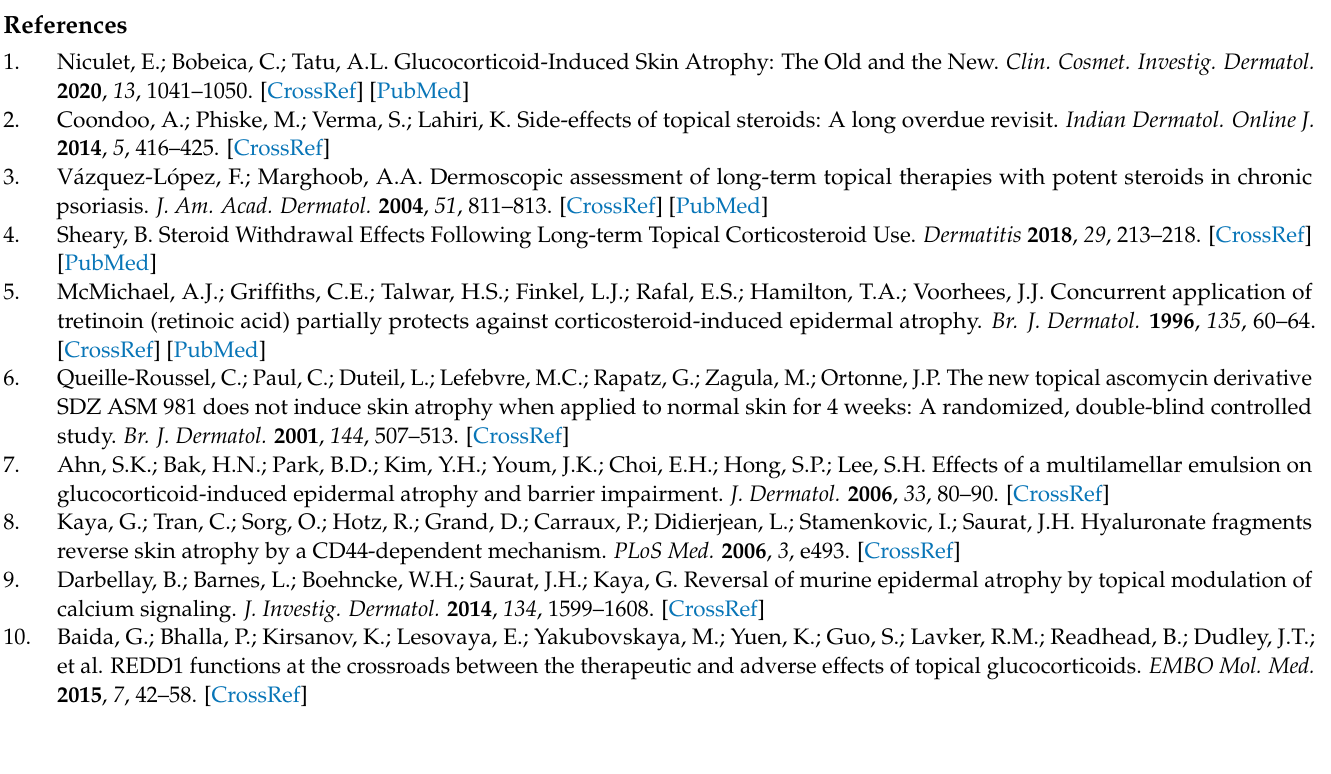
Figure S3: Atrophy of subcutaneous fat after finishing 12-days FA treatment; Figure S4: Validation of transcriptomic and proteomic analyses; Table S1: Normalized RNA-Seq data; Table S2: Normalized proteomic